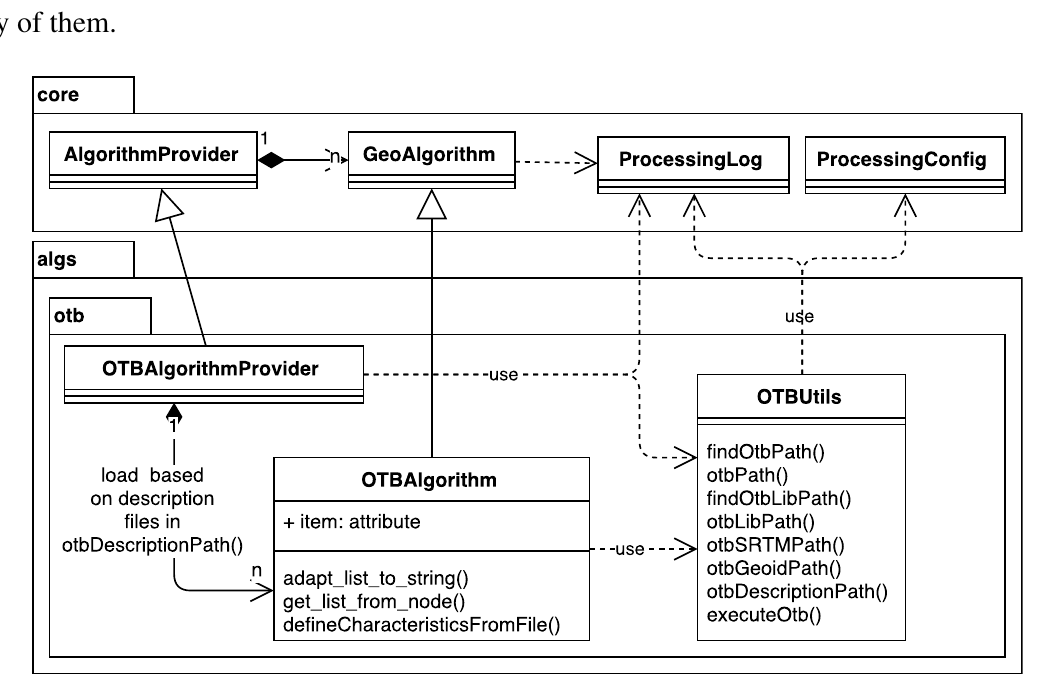
Figure 14. Class diagram of the otb package and its connections to other